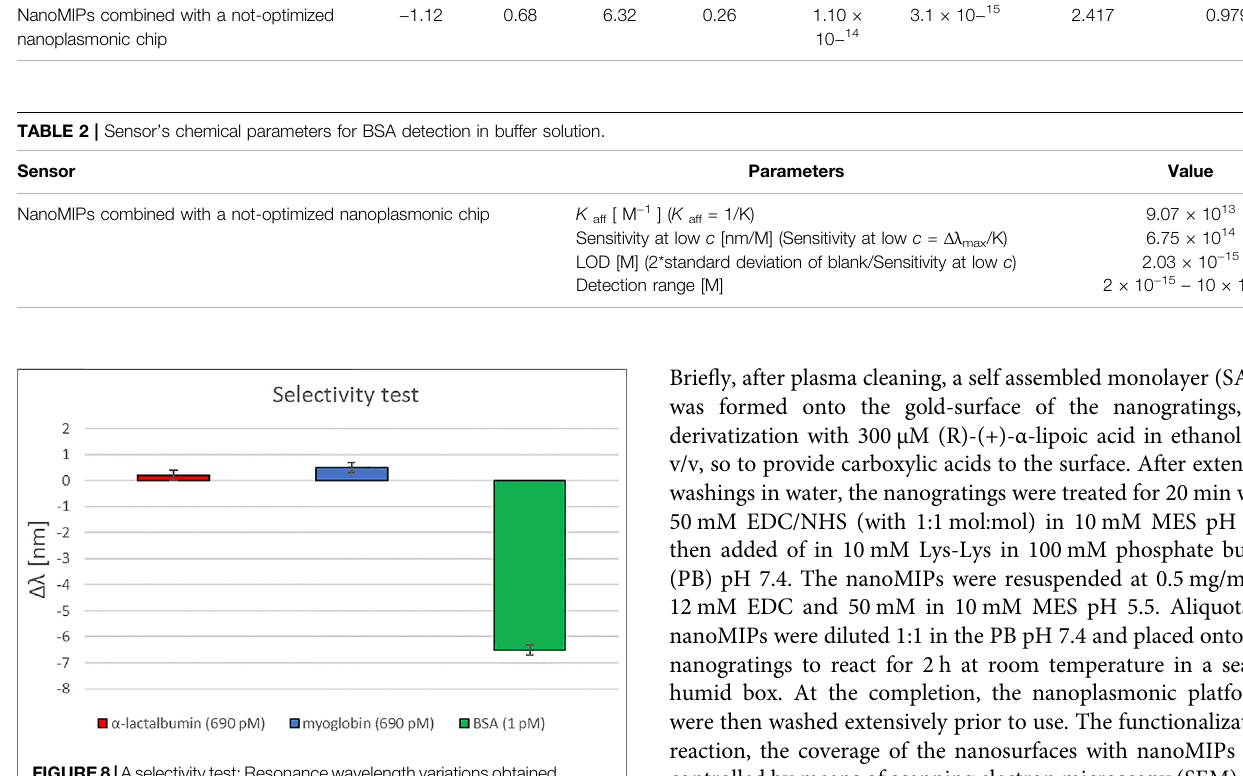
FIGURE8| Aselectivitytest:Resonancewavelengthvariationsobtained by different substances.